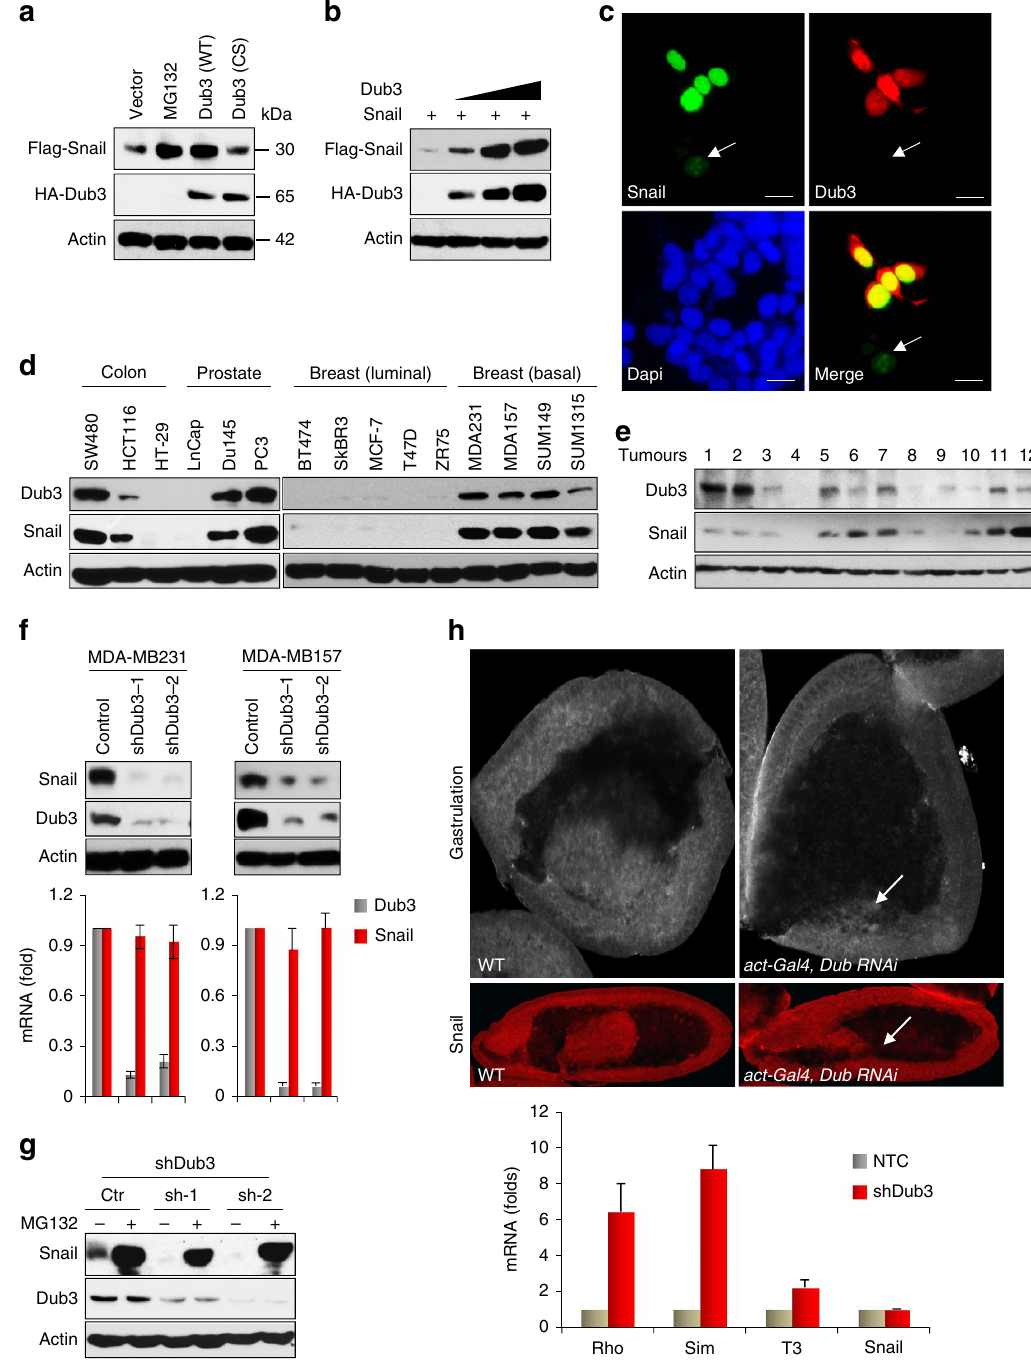
Figure 1 | Dub3 stabilizes Snail1. ( a ) Flag-Snail1 was co-expressed with HA-tagged Dub3 (either wild-type, WT, or catalytic inactive C89S mutant, CS) in HEK293 cells or cells were treated with MG132 for 6h. Expression of Snail1 and Dub3 were assessed by western blot. ( b ) Flag-Snail1 was co-expressed with increasing amounts of HA-Dub3 in HEK293 cells. Lysates were subjected to analysis by western blot. ( c ) GFP-Snail1 was co-expressed with HA-Dub3 in HEK293 cells. After fixation, the cellular location of Snail1 (green) and Dub3 (red) was examined by immunofluorescent (IF) staining using anti-HA antibody and visualized by fluorescence microscopy (nuclei were stained with Dapi; blue). Arrowhead identifies a cell expressing only GFP-Snail1 but not Dub3. Scale bars, 25 m m. ( d ) The protein expression of Dub3 and Snail1 in various cancer cell lines was analysed by western blot. ( e ) Expression of Dub3 and Snail1 from 12 human breast tumours (fresh frozen) was analysed by western blot. ( f ) The protein expression of Dub3 and Snail1 from MDA-MB157 and MDA-MB231 cells stably transfected with control or two individual Dub3 shRNAs was analysed by western blot and the mRNA was detected by real-time PCR (mean ± s.e.m. in three separate experiments). ( g ) The protein expression of Dub3 and Snail1 from MDA-MB157 cells stably transfected with control or two individual Dub3 shRNAs and treated with or without 10 m M MG132 for 6h was analysed by western blot. ( h ) Gastrulation and Snail1 expression were detected in Drosophila embryos and the mRNA was detected by real-time PCR using stage 11 cells (mean ± s.e.m. in three separate